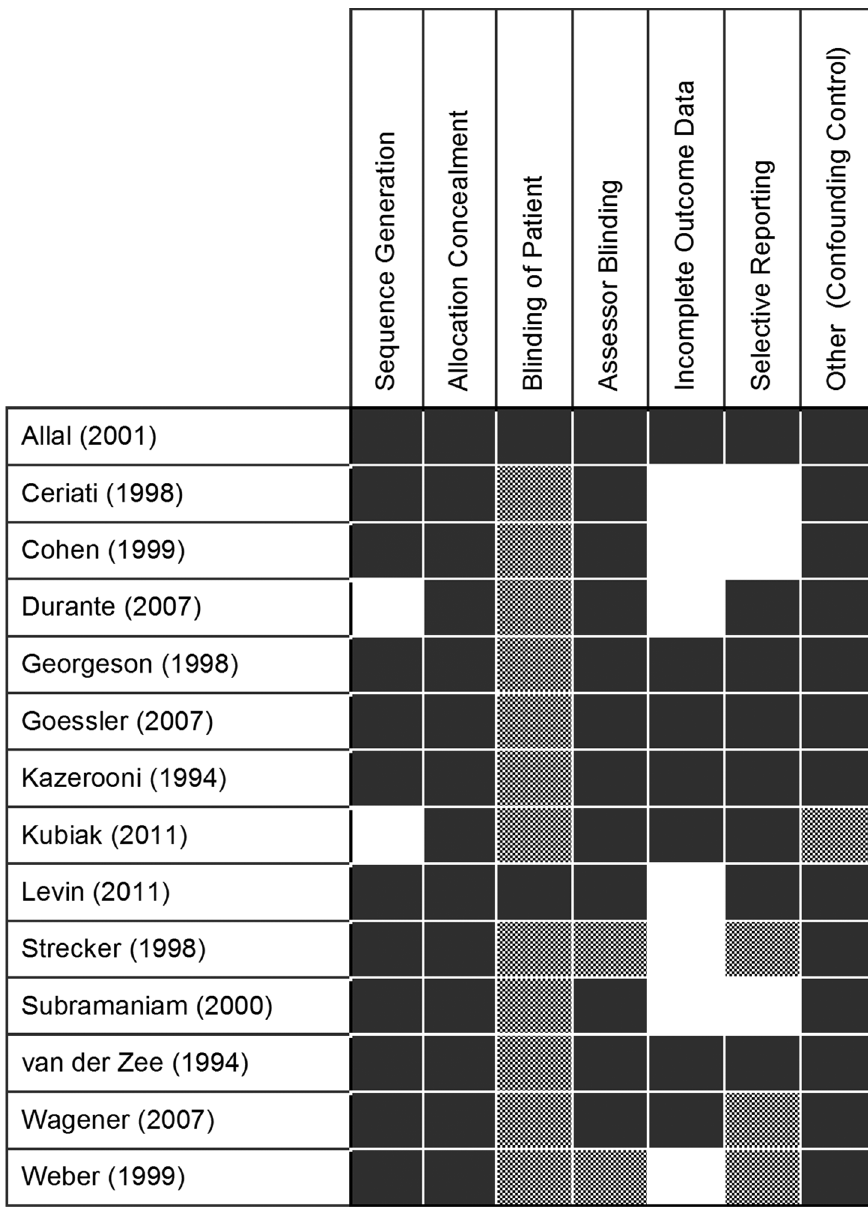
Figure 6. Modified Cochrane Risk of Bias evaluation of study quality. Shaded: high risk of bias; checkered: unclear or indeterminate risk of bias; not shaded: low risk of bias.